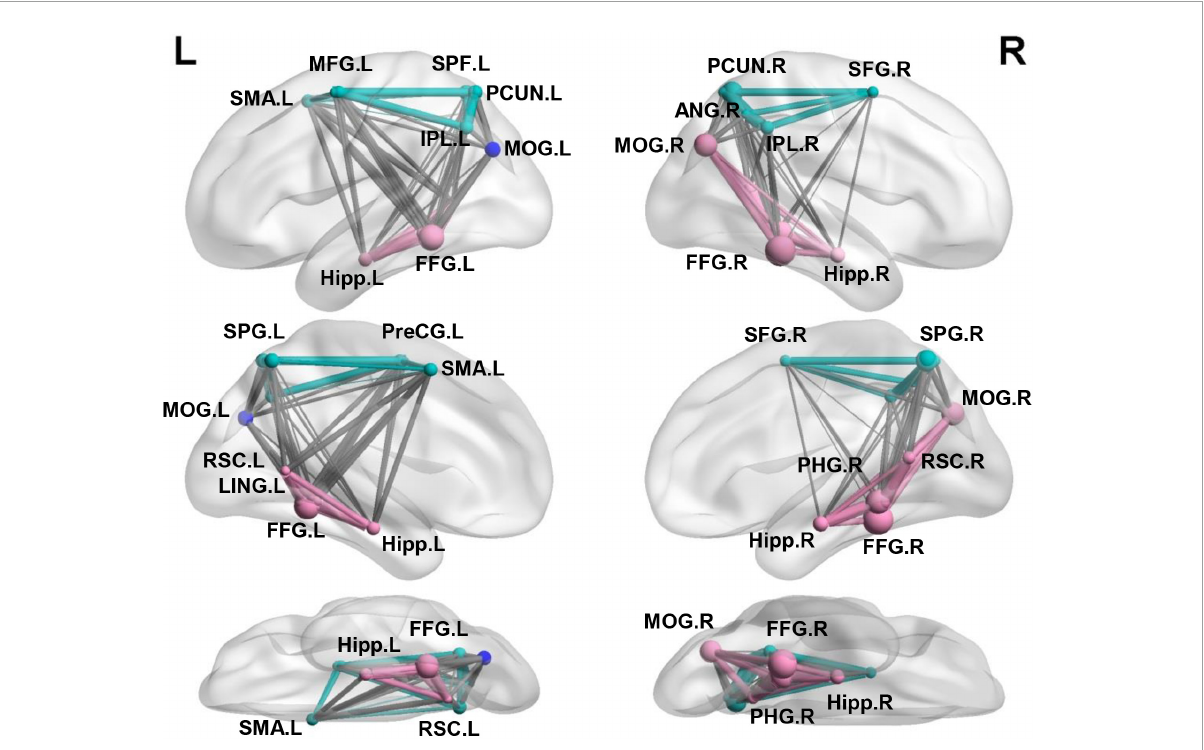
FIGURE2 Separating the navigation network into the ventral and other two subnetworks. Three modules identified using modular analysis: ventral subnetwork (red) including most well-established regions for navigation and other two subnetworks (green and blue) including multiple regions in the dorsal parietal-frontal